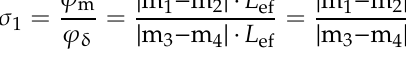
Figure 14. Partial enlarged drawing of flux lines.